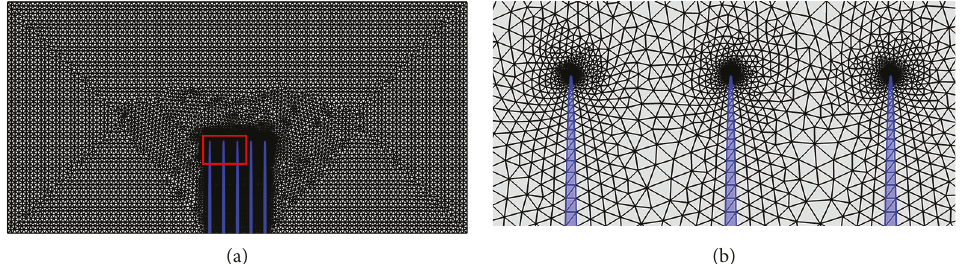
Figure 2: Meshed model with triangular grids. The grids within the fracture network zone are re fi ned to ensure convergence and accuracy of the numerical